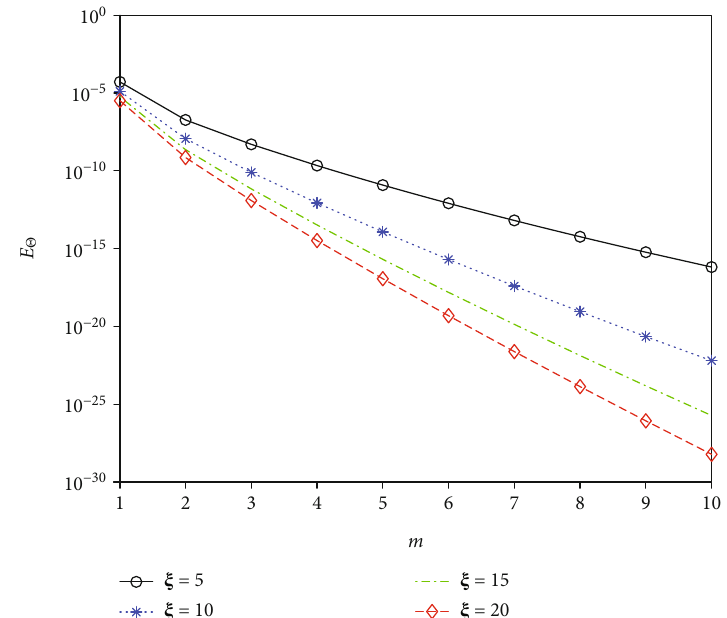
ð m Þ of LSPM series approximation for di ff erent values of ξ , when n = Figure 26: Variation of solution error E Θ against increasing order = 0 : 6, Ω = 0 : 1, and He = 0 : 2 : 0 : 5, K = 0 : 5, Pr = 10, S = 3, N R